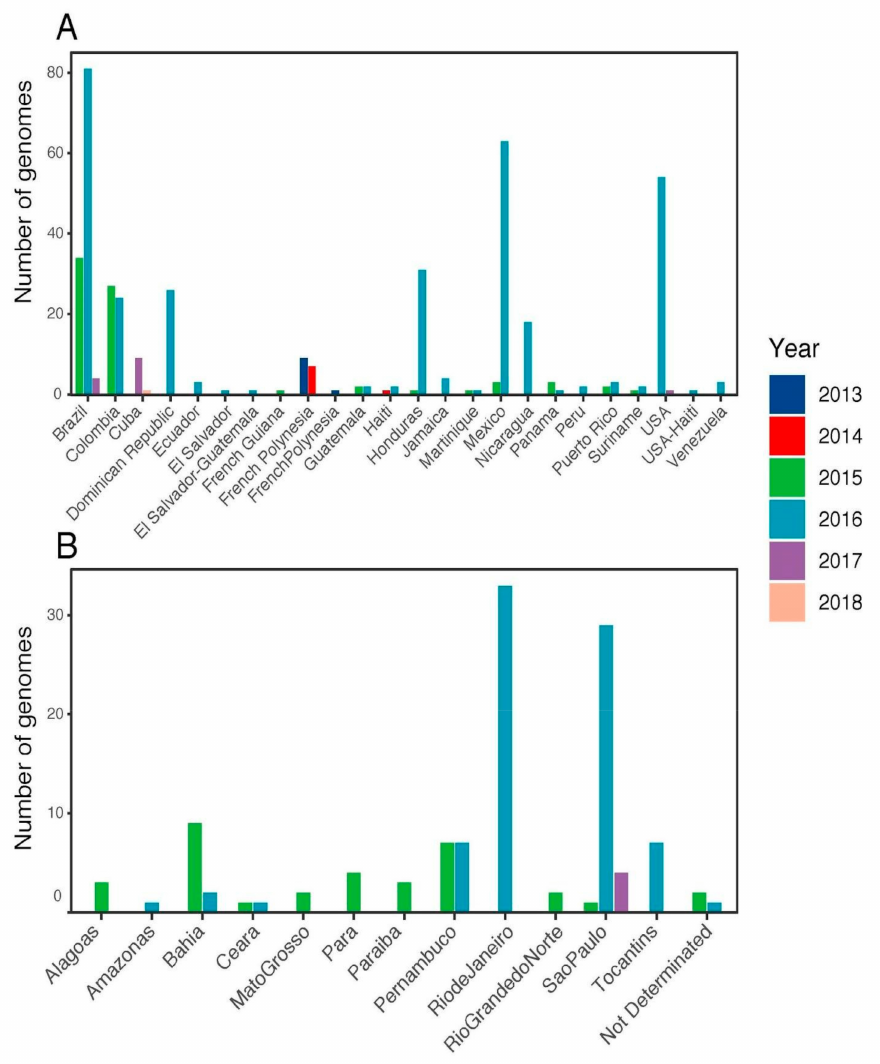
Figure 1. Place and year of sampling of the Zika virus (ZIKV) genomes analyzed in this study. ( A ) American countries and French Polynesia. ( B ) Brazilian states by year before the down